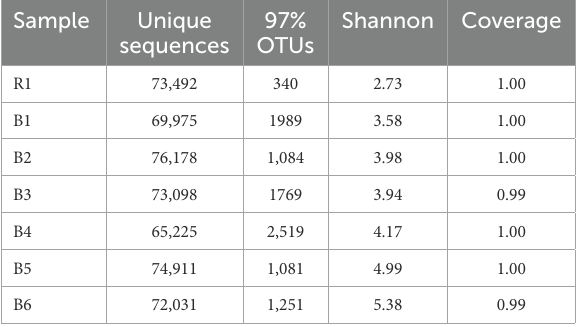
TABLE 1 Diversity and richness estimators for pyrosequence